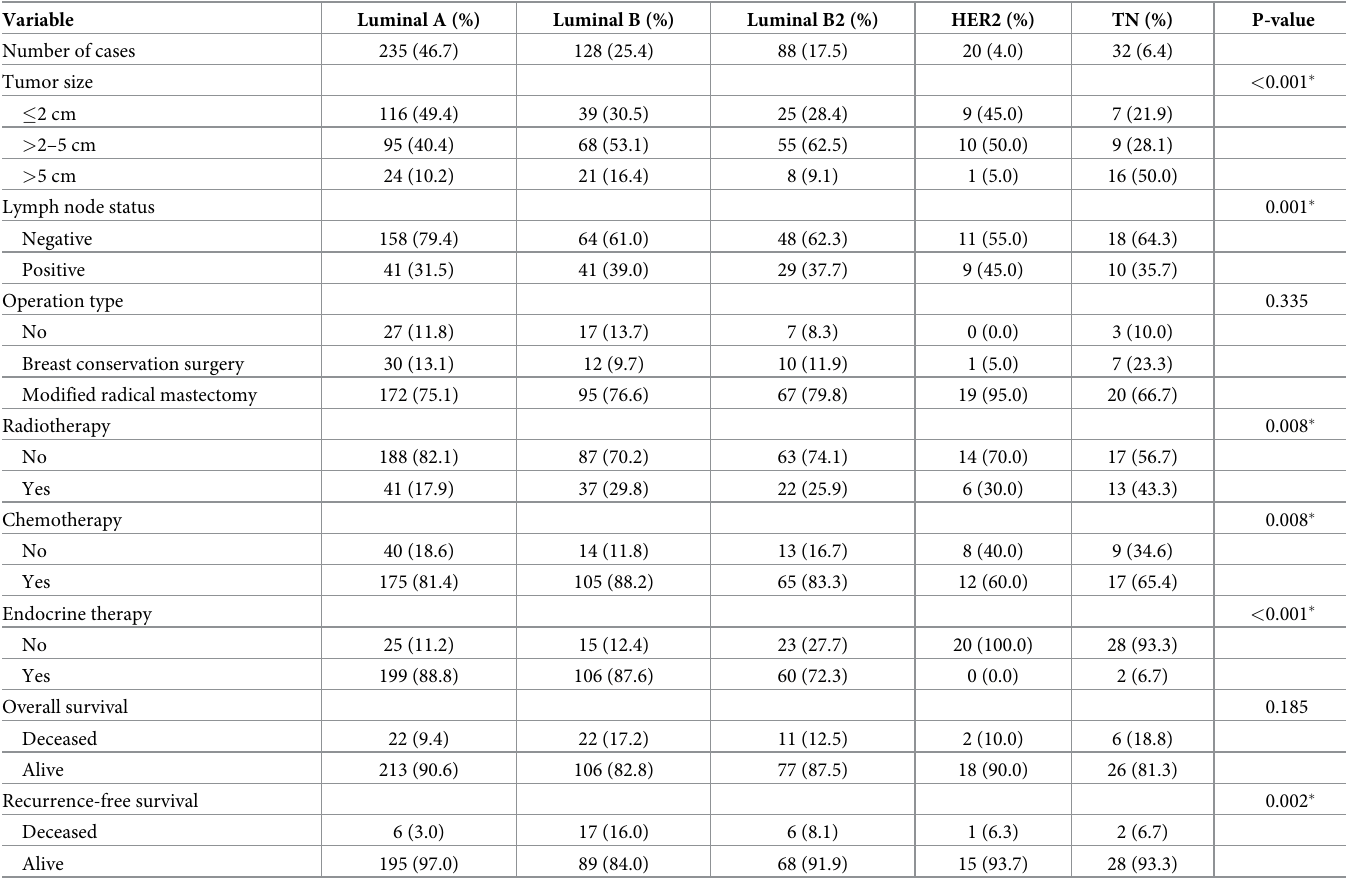
Table 1. Clinicopathological characteristics of all patients according to breast cancer subtype (age > 65, n =